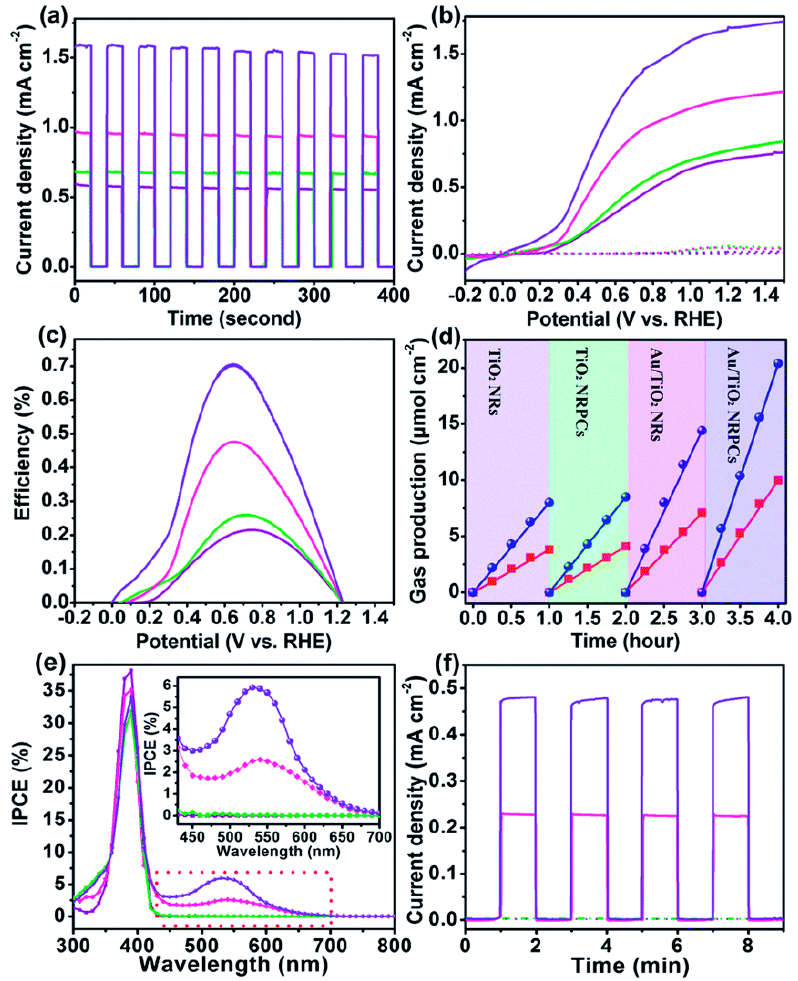
Figure 27. Comparing the PEC properties of four different photoanodes: TiO 2 nanorods (dark purple solid line), TiO 2 nanorod photonic crystals (green solid line), Au/TiO 2 nanorods (pink solid line), and Au/TiO 2 nanorod photonic crystals (pale purple solid line) [257]. ( a ) Chronoamperometry measurements performed at an external potential of 1 V vs. Reversible Hydrogen Electrode (RHE). The on/off circles indicate simulated sunlight illumination. ( b ) Linear sweep voltammetry measurements for a scan rate of 50 mV/s under dark (dotted lines) and illuminated conditions. ( c ) Photoconversion efficiency as a function of applied potential versus RHE. ( d ) The resultant evolution of H 2 and O 2 gases for the four photoanodes under simulated sunlight illumination. Of particular note are the IPCE results in ( e ) which displays the shapes of the IPCE active spectra of the various Au/TiO 2 composite photoanodes. PEC activity within the visible light regime is observed due to the presence of the Au noble metal nanoparticles. Furthermore, the shapes of the IPCE spectra as shown in the inset are noted to be similar to that of LSPR absorption spectra of Au nanoparticles. ( f ) Amperometric I-t curves for the four different photoanodes for repeated on-off cycles of simulated sunlight. Reprinted with permission from Ref [257] Copyright Royal Society of Chemistry (2014).